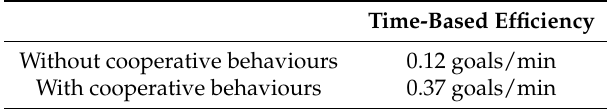
Table 1. Time-based efficiency of the transport task using the two